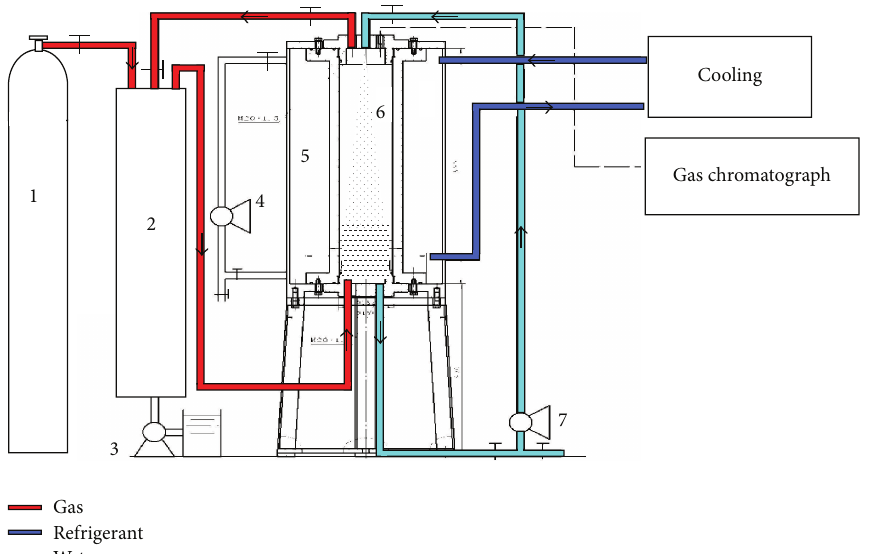
Figure 1: Process flow diagram hydrate formation experiment device.